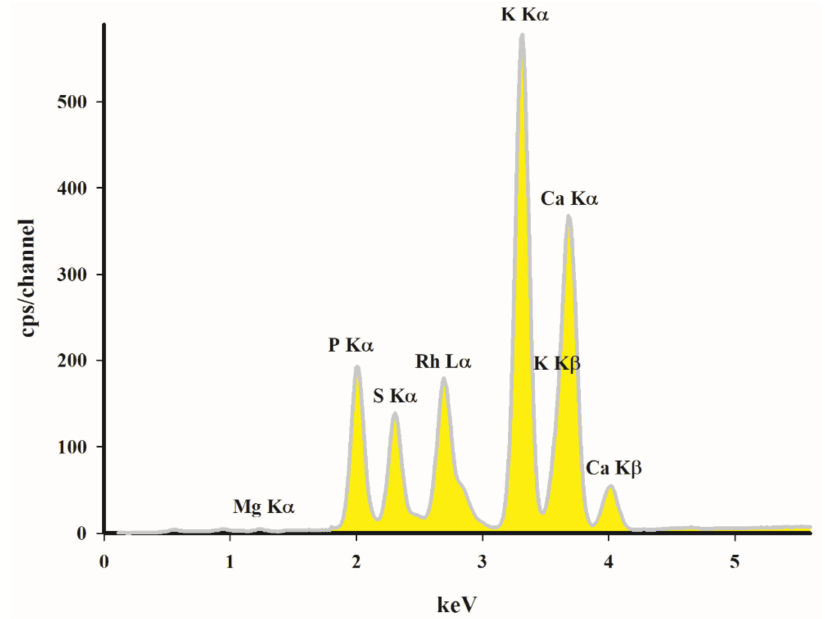
Figure 4. EDXRF spectrum of studied carbon biochar sorbent. Granulometric analysis of the samples suspended in methanol was performed with a MasterSizer 3000 laser apparatus. The obtained biochar revealed the dominant fraction with a size of 119–844 µ m and an average specific surface of 45.2 m 2 · kg − 1 (Figure